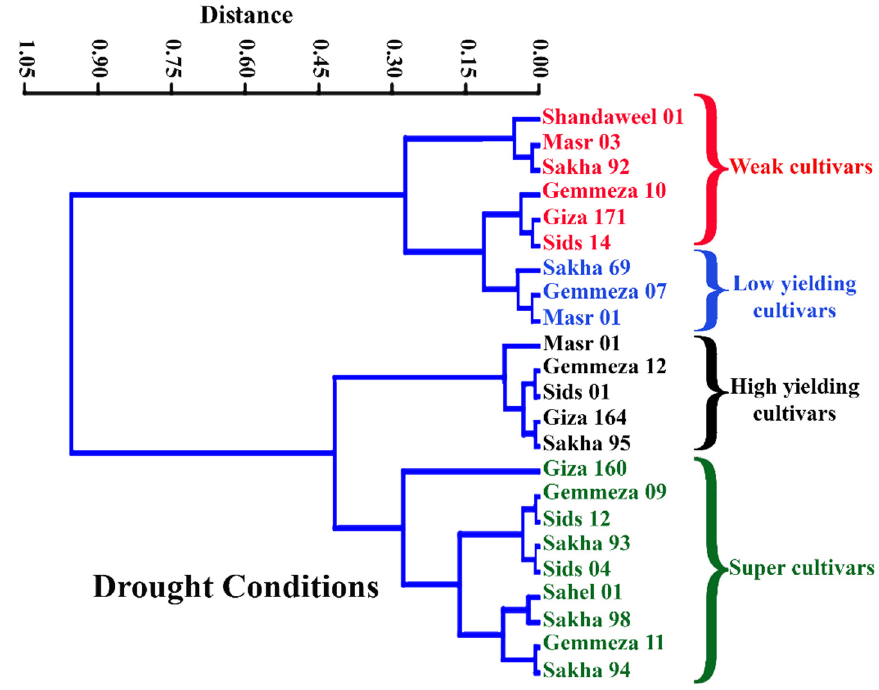
Figure 11. Dendrogram using Ward’s method among groups showing the classification of genotypes based on the combined grain yield per m 2 under stress conditions.